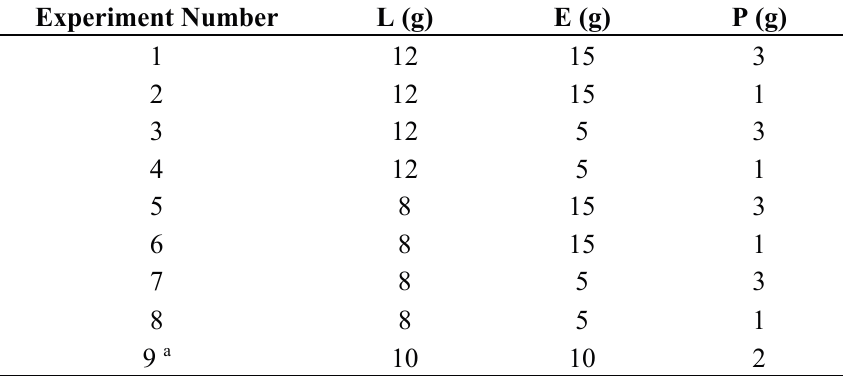
Table 3. Ingredients concentration used in optimization experiments of oiling bath preparation. L, rapeseed lecithin ethanol soluble fraction; E, anhydrous ethanol; P, Polysorbate